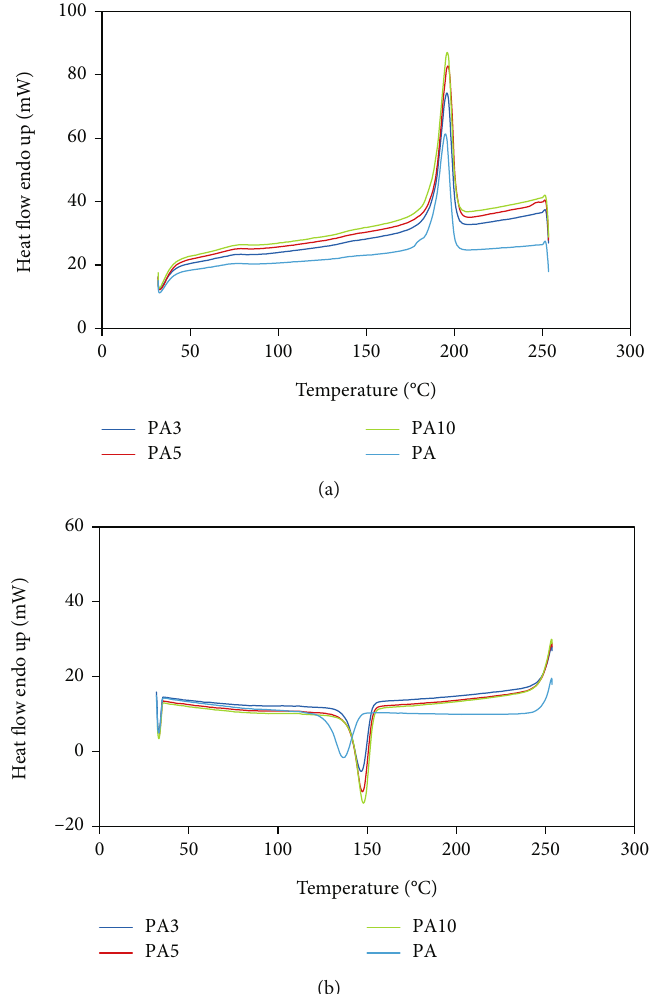
Figure 5: DSC results of PA and its composites (PA3, PA5, and PA10), showing (a) endothermic melting peak (peak up) and (b) exothermic cooling peak (peak